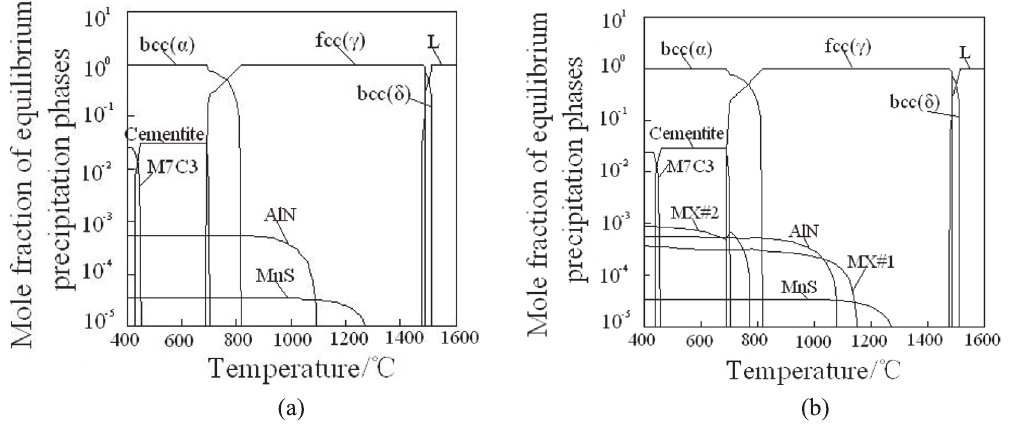
Fig. 1: The temperature dependences of type and mole percentage for equilibrium precipitation phases in Q345E: (a) alloyed with Nb and V; (b) without addition of Nb and